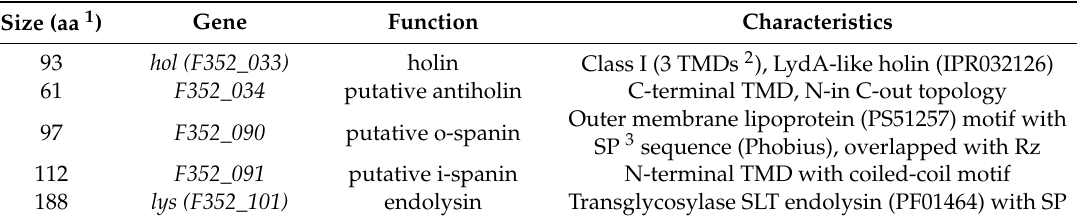
Table 1. Lytic genes predicted in Fletchervirus phage